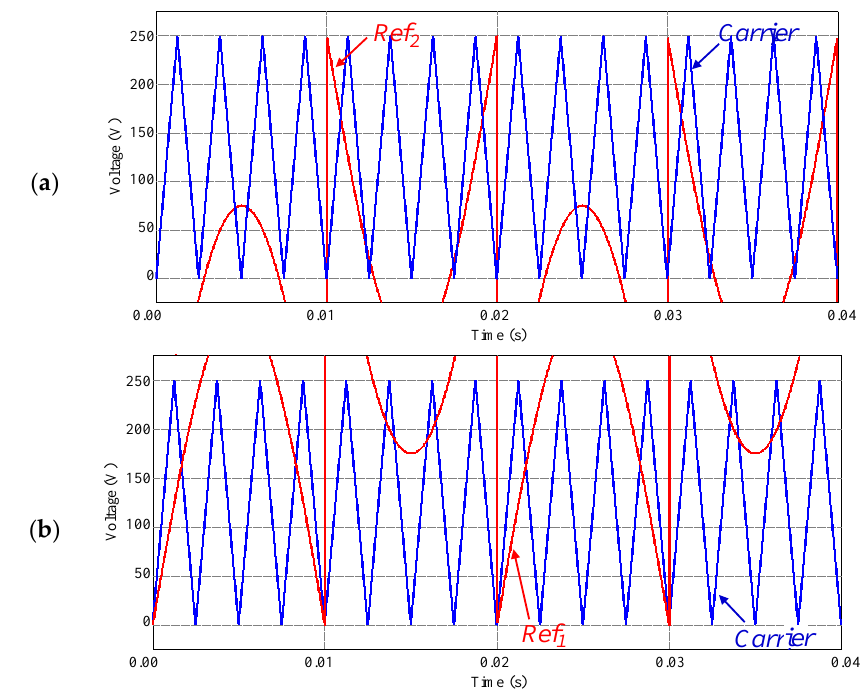
Figure 7. Adapted reference signals used in the modulation strategy: ( a ) Ref 2 ; ( b ) Ref 1 .